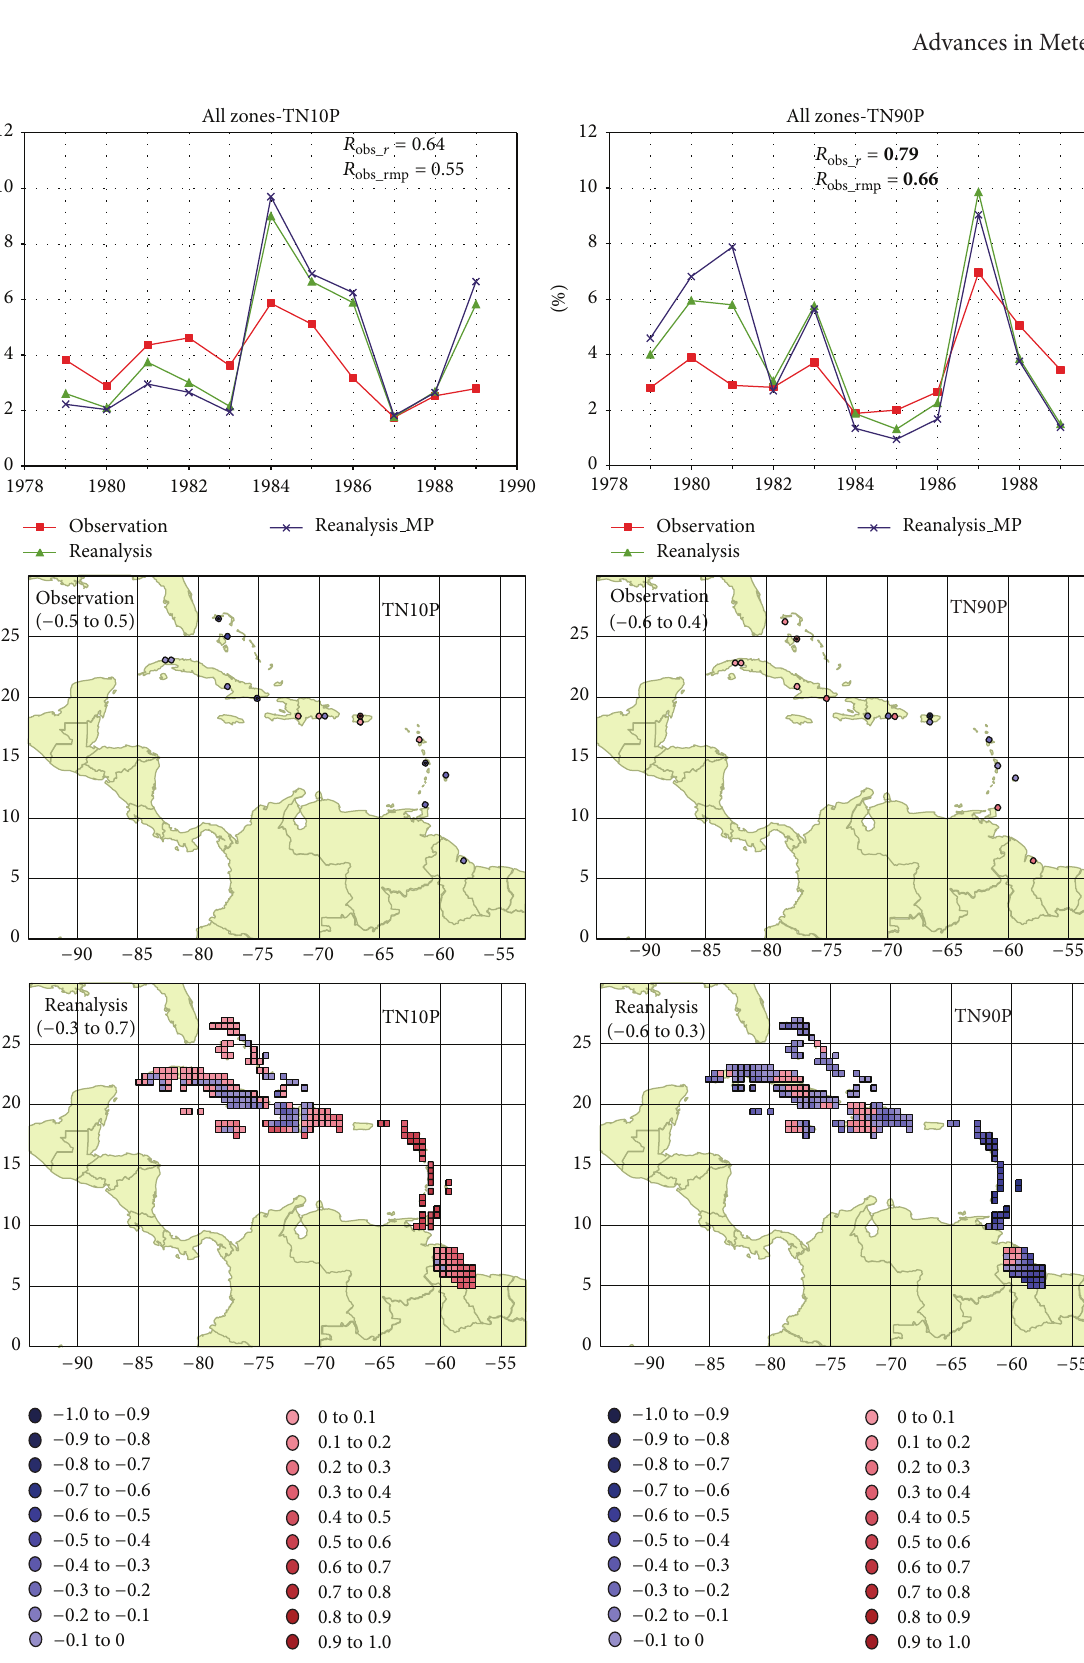
Figure 4: Temporal and spatial variability of cool nights (TN10P) and warm nights (TN90P). Graphs show average time series for entire domain for observation (red), PRECIS-reanalysis (green), and reanalysis matching points (purple) for 1979–1989. Maps of observed trends and PRECIS-reanalysis trends for 1979–1989 are shown in the middle and bottom panels, respectively. Blue colour indicates negative and red colour indicates positive trends. Statistically significant trends are indicated with white